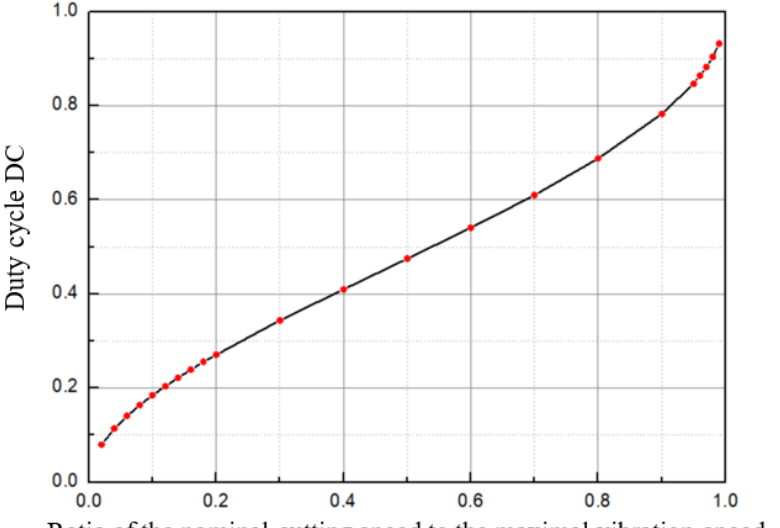
Figure 2. Relationship between the duty cycle and the speed ratio.